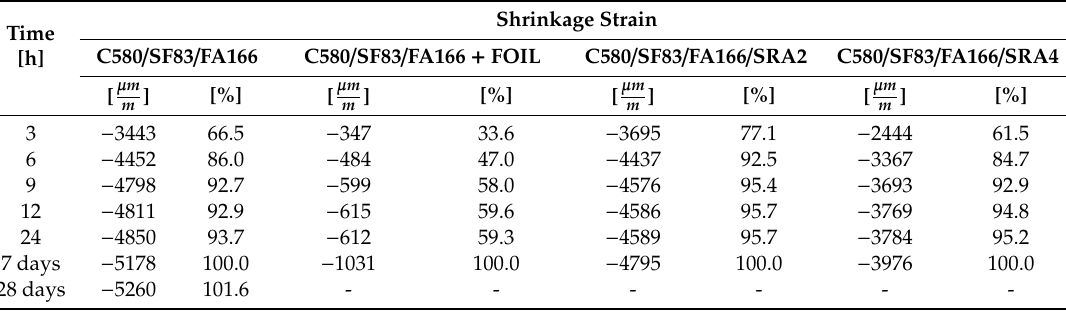
Table 4. Concrete shrinkage over